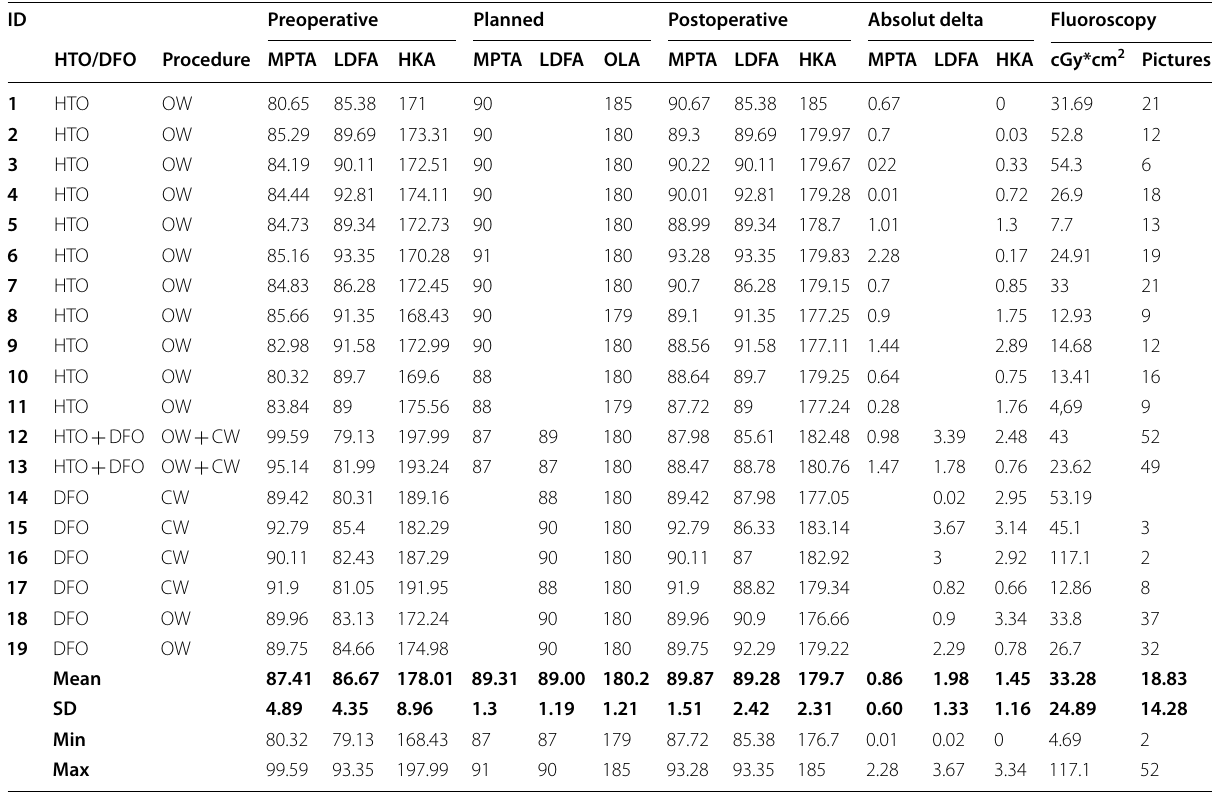
HKA below 180° is defined as varus alignment